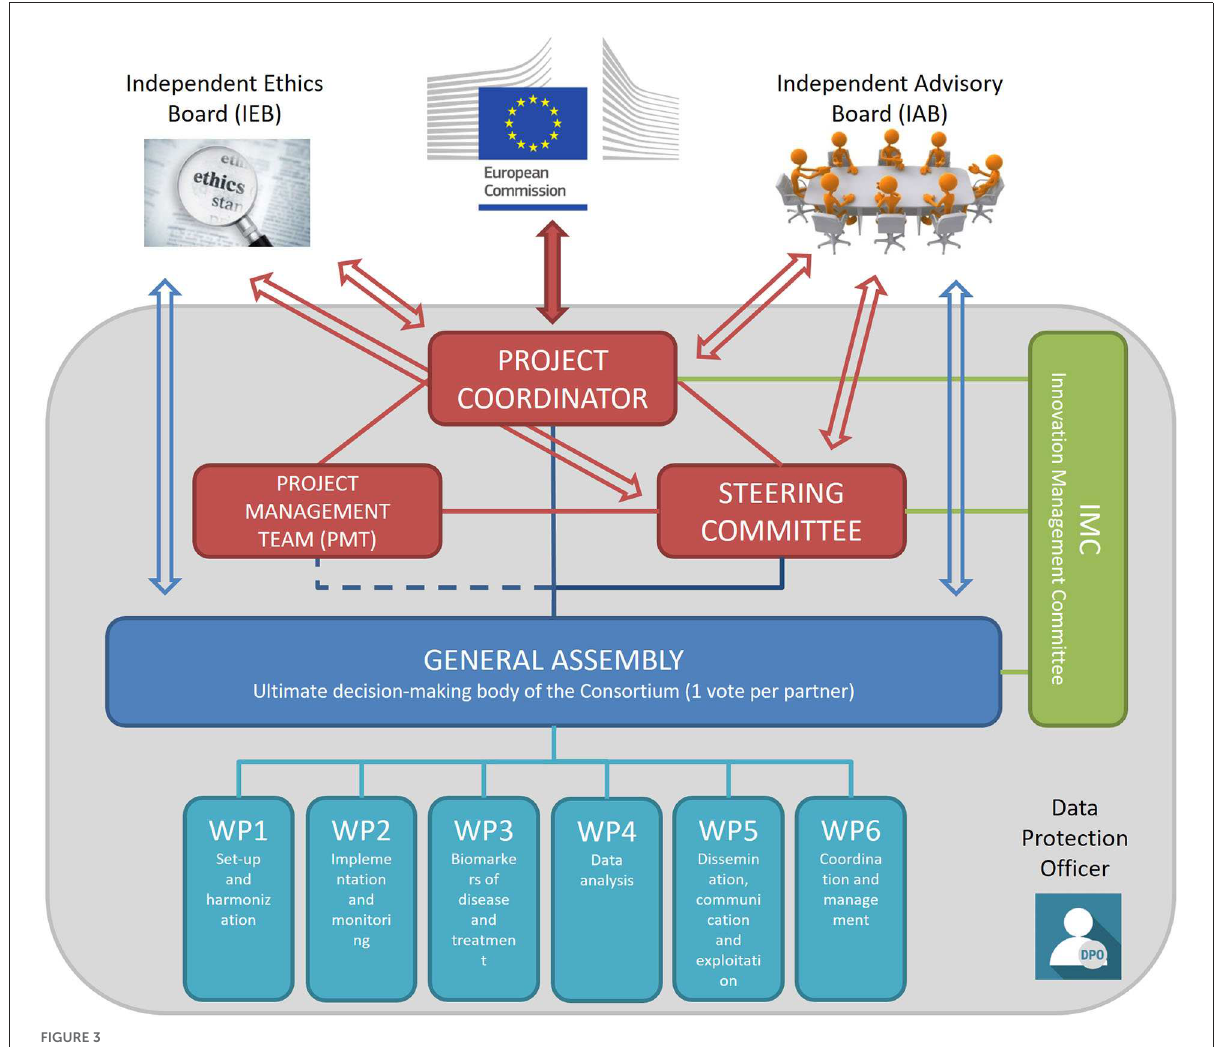
FIGURE3 TUDCA-ALS management structure. Coordinating bodies are shown in red. The Project Coordinator is responsible for the core management tasks and the overall progress of the project; the Project Management Team is in charge of the project management and administration, in close collaboration with the Project Coordinator; the Steering Committee implements decisions taken by the General Assembly and reviews the project results. The General Assembly (shown in blue) is the decision-making body of the project overseeing the six work packages. The Innovation Management Committee (shown in green) monitors the principles for Intellectual Property rights and the dissemination and exploitation of project results. The Independent Advisory Board provides external advice on the conduct of the project, to bring maximum impact. The Independent Ethics Board provides guidance on ethical issues. The Data Protection Officer assures that trial activities conform to current EU and national legislation.